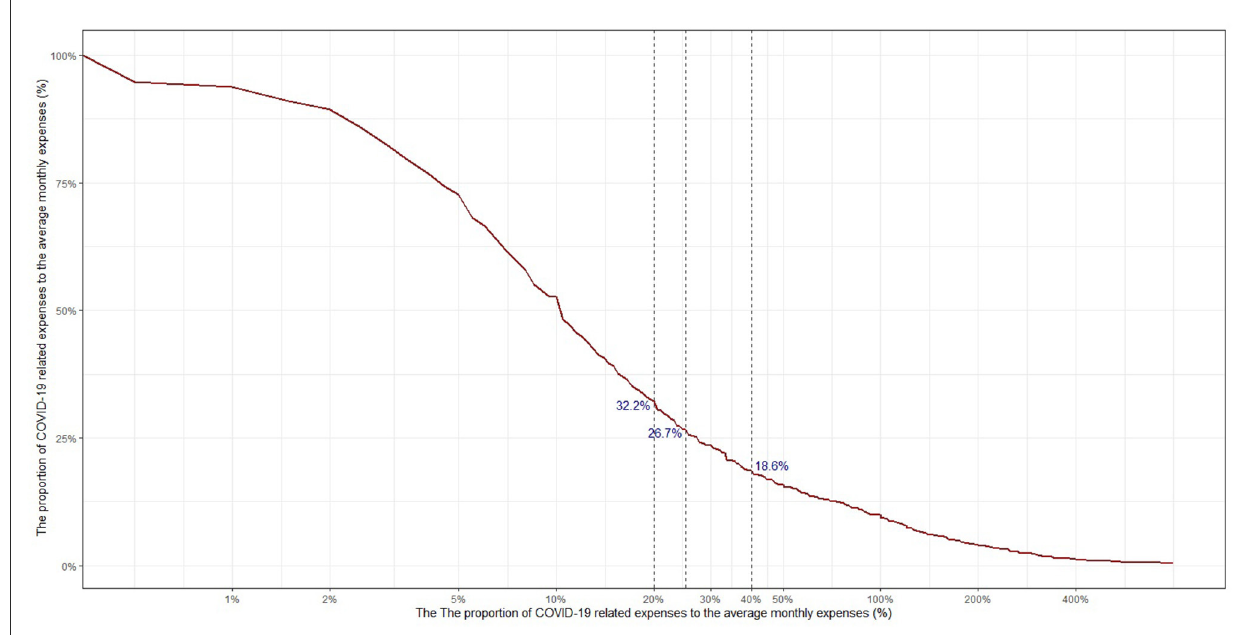
FIGURE1 The proportion of individuals who experienced catastrophic health spending related to COVID-19 expenses.